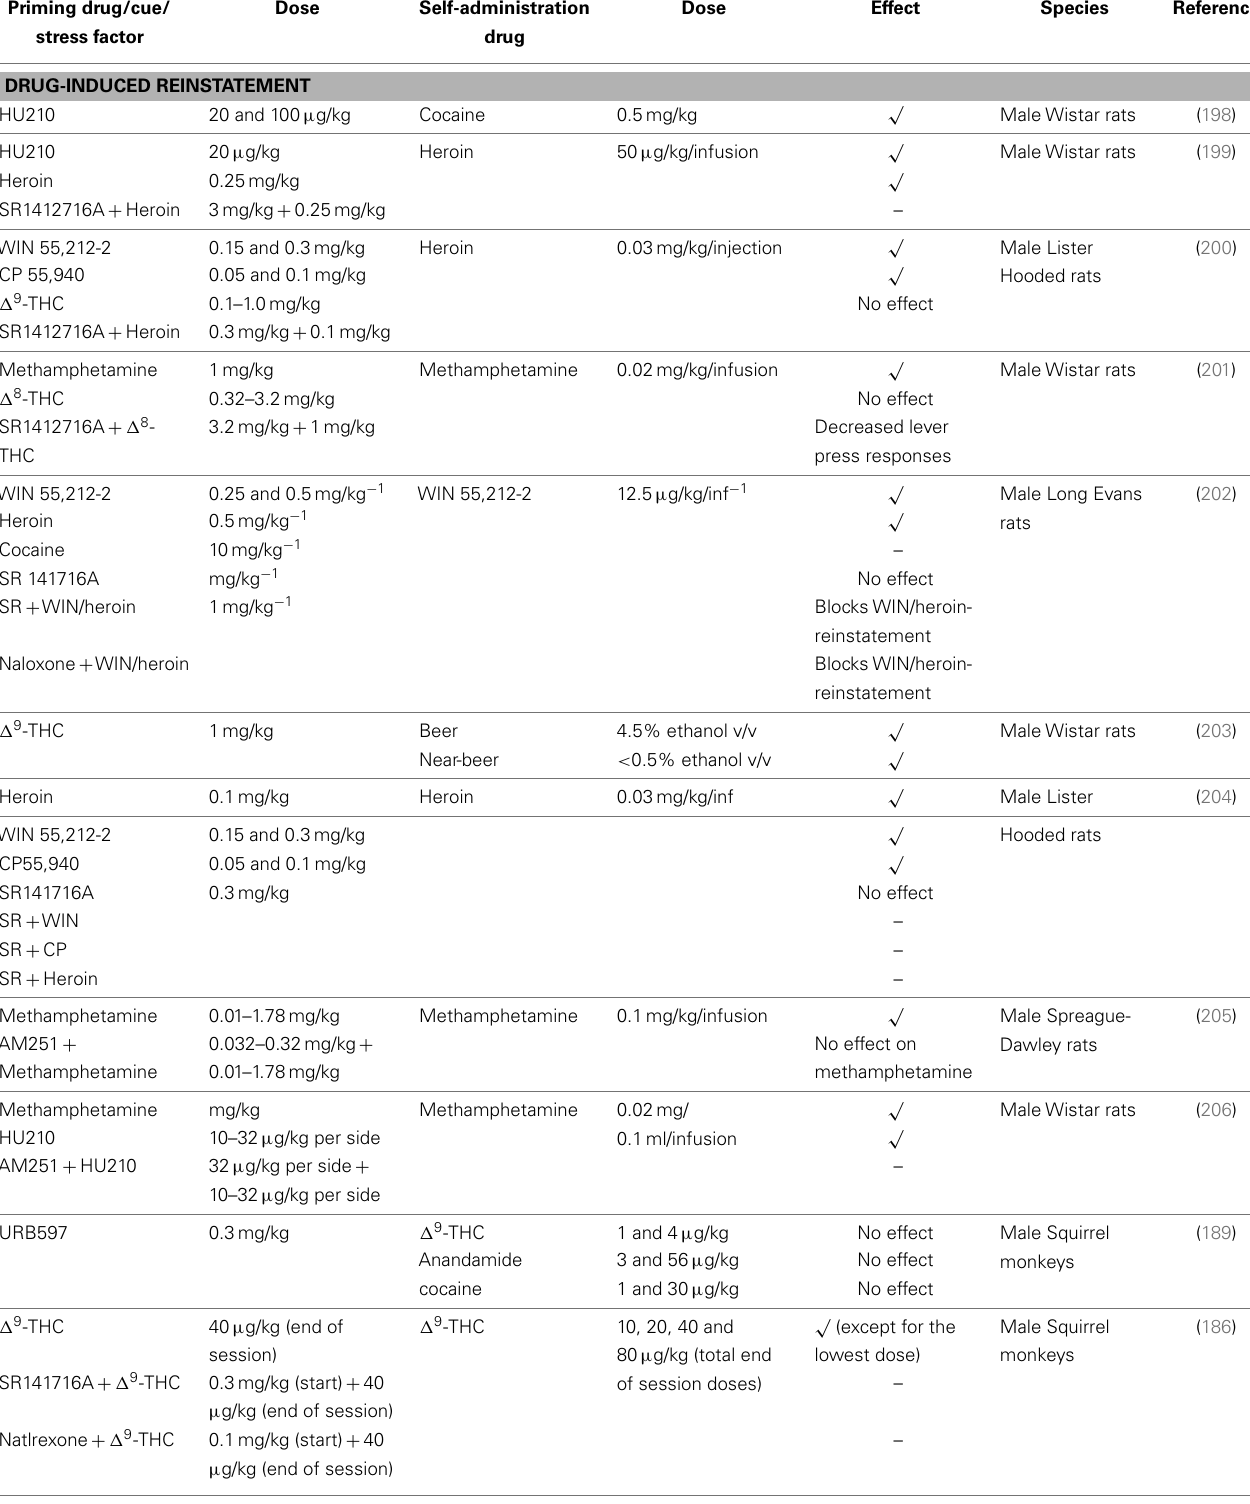
Table 4 | Cannabinoid effects on reinstatement of drug-seeking behavior in experimental animals . Priming drug/cue/ stress